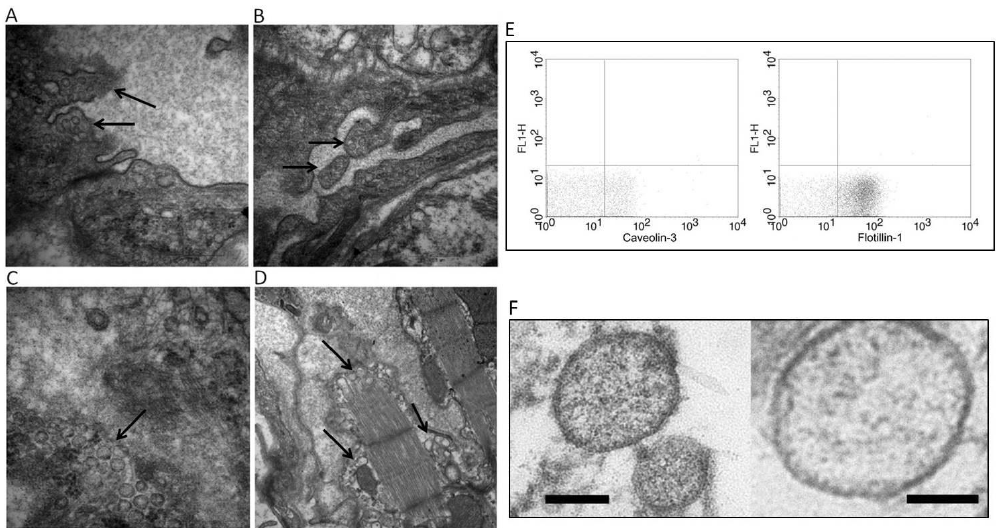
Figure 2. Electron microscopy of heart tissue. ( A , B ) Budding of the vessel wall to release the exosomes into the lumen (black arrows); ( C ) exosomes in the extracellular space; ( D ) exosomes released by myocyte fiber. Modified from Reference [16]. ( E ) Detection of proteins on cardiomyocyte (CM) EXO surface with flow cytometry. Mouse anti-caveolin-3 was detected on approximately 30% of EXOs (left), while mouse anti-flotillin-1 was detected on approximately 80% of EXOs. The distribution of EXOs presenting caveolin-3 and flotillin-1 indicates that the sample contains more than one population of EXOs. ( F ) Transmission electron microscopy of purified CM microvesicles (MVs)/EXOs. On the left, MVs/EXOs that display an electron-dense appearance are shown; on the right, MVs/EXOs that display an electron-lucent appearance are shown. Scale bar: 100 nm. Modified from Reference [15].